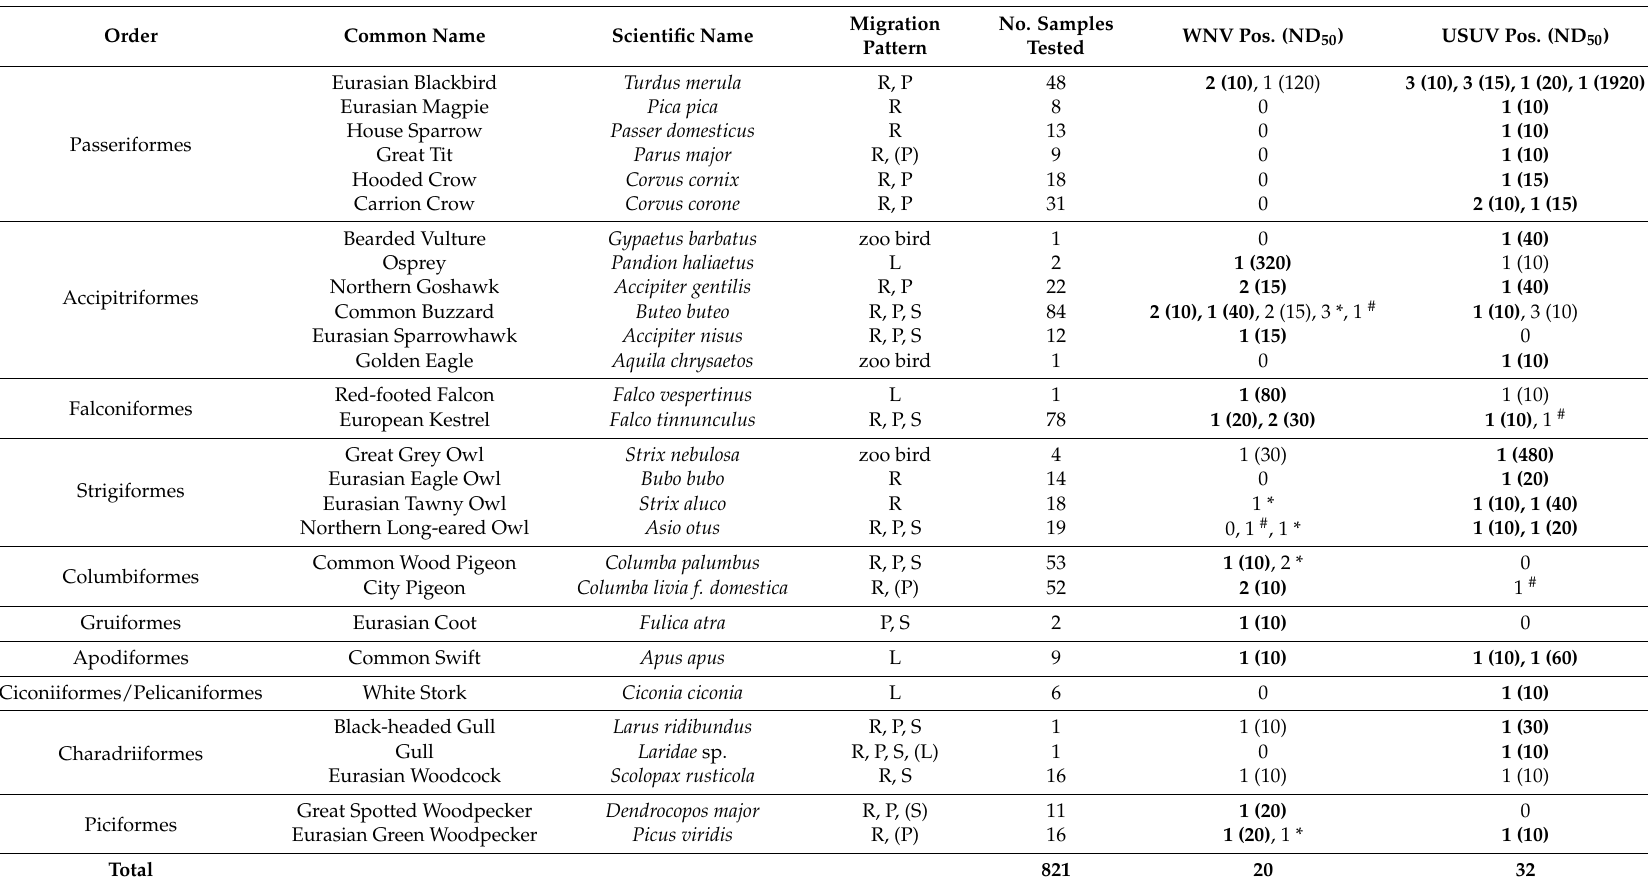
Table 5. WNV and USUV positive neutralization assay results (positives highlighted in bold) from wild bird serum samples in